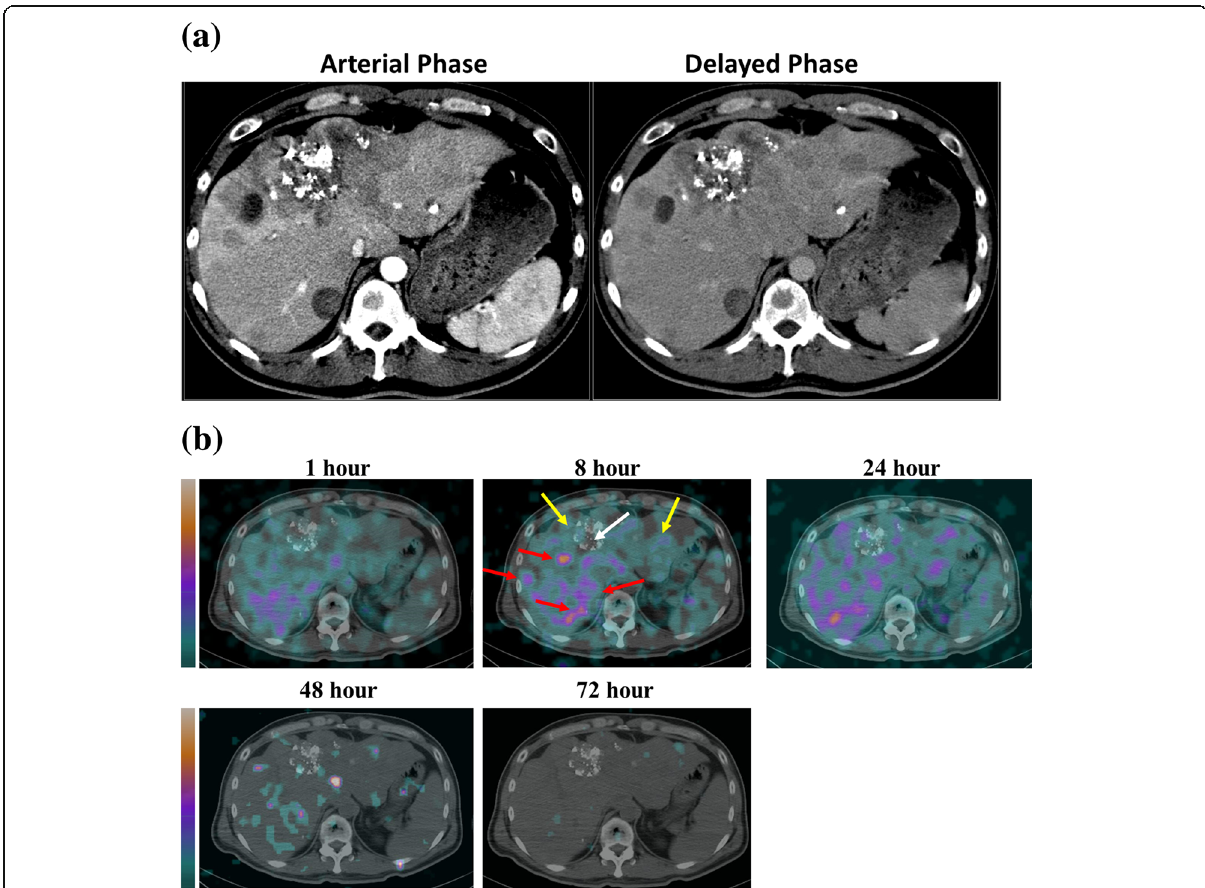
Fig. 2 a Contrast CT image of a liver cancer patient (Pt. 3) with pulmonary and bone metastases displayed lipiodol retention resulted from transarterial embolization and multiple confluent nodular and mass lesions at both lobes of liver. b 188 Re-liposome SPECT/CT imaging of tumor targeting and uptake in Pt. 3 at different time points after injection. The patient had previously received transarterial chemoembolization (TACE), which left a region with hyperdense lipoid as well as central necrotic area (white arrow). Several necrotic lesions show hypodense CT image and less radioactivity. Some viable tumor masses were either displayed as solid nodules or formed a rim-like structure surrounding the necrotic regions (red arrows). The radioactivity uptake of normal liver was indicated by yellow